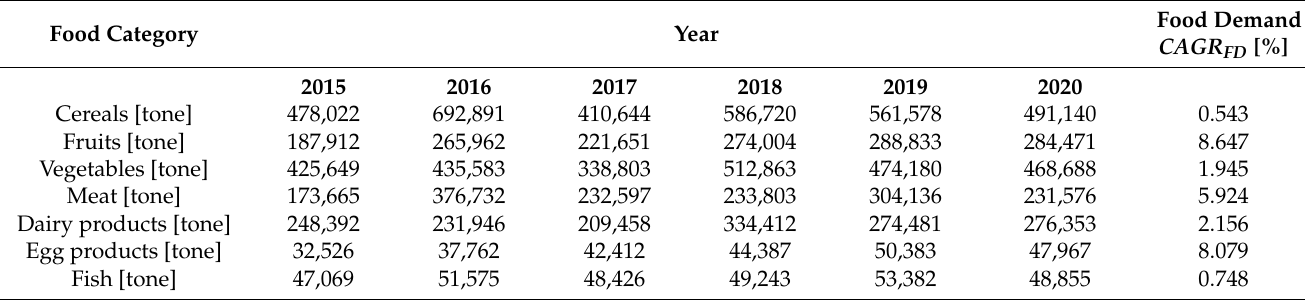
Table 1. Food demand in Qatar from 2015 to 2020